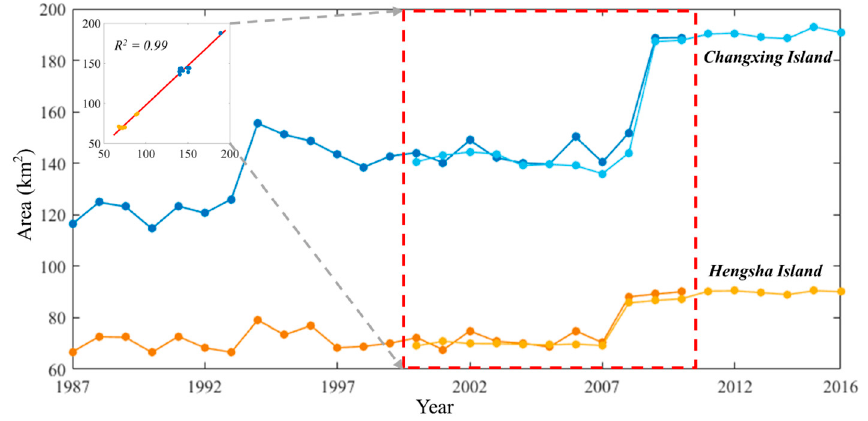
Figure 15. Different time series of the annual land area of Changxing Island and Hengsha Island derived from the TM and ETM+ data. The time series in the red box was used for the analysis. The inset figure shows the relationship between land areas derived from the TM and ETM+ data during the 2000–2010 period, which displays good agreement ( R 2 = 0.99, p -value < 0.001).